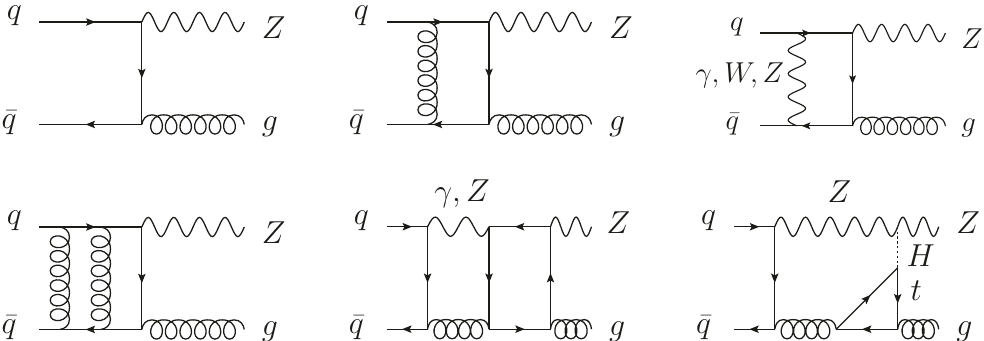
Figure 1 . Examples of Feynman diagrams that contribute to Z + j production at LO (top-left) and virtual corrections at NLO QCD (top-middle), NLO EW (top-right), NNLO QCD (bottom-left) and mixed NNLO QCD-EW (bottom-middle and